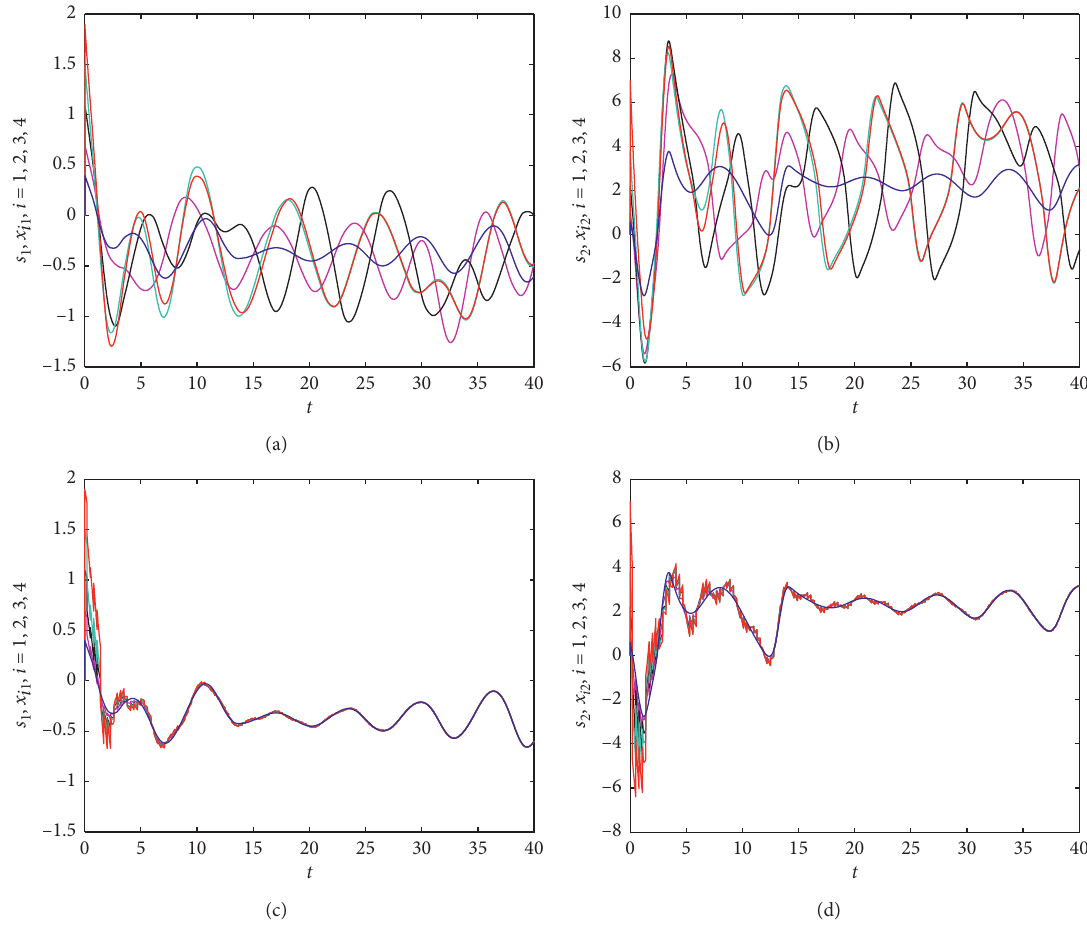
Figure 3: State trajectories for Example